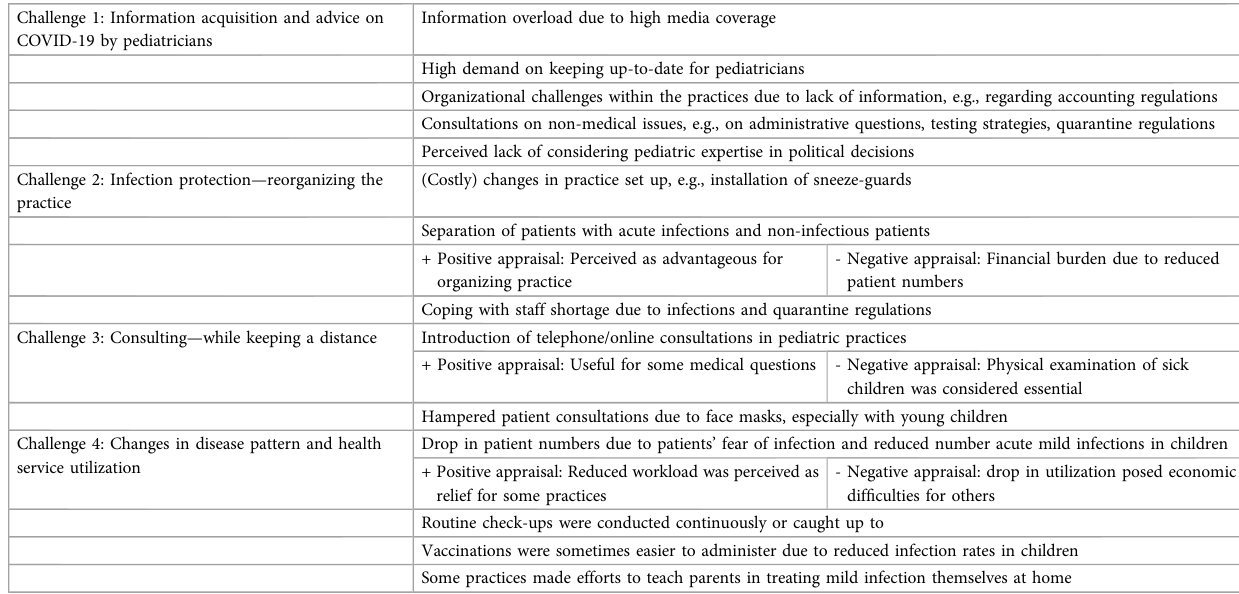
TABLE 2 Overview over the main challenges for pediatricians during the COVID-19 pandemic. Challenge 1: Information acquisition and advice on COVID-19 by